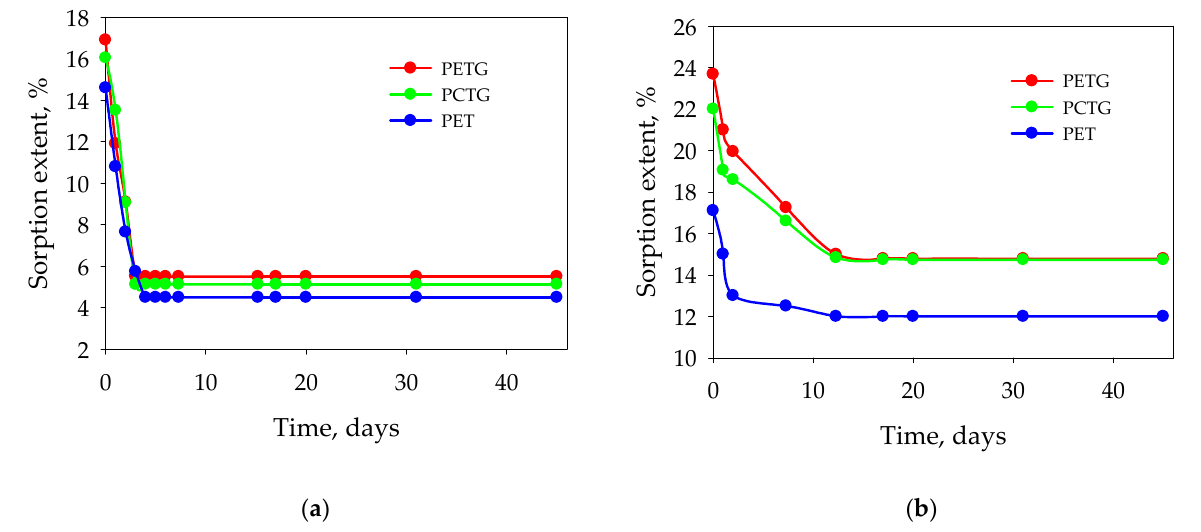
Figure 4. Desorption of acetic acid esters from polyesters: ( a )—ethyl acetate, ( b )—butyl acetate. A long-term study of the residual ester content shows a very slow decrease in ester content over time. At 20 ◦ C and ambient pressure, the ester content can decrease to 0.9% by weight after one year of desorption. The slow rate of desorption in the equilibrium zone is significantly affected by temperature. At 60 ◦ C, complete desorption for PETG and ethyl acetate can be achieved after 27 days. At 60 ◦ C and vacuum (pressure 10 kPa), complete desorption for the same system is achieved in 36 h. For other polyesters, complete desorp- tion can be reached in a similar way but within a different time period. The desorption of esters from polyesters is relatively slow, which offers the possibility to control the residual ester content by choosing specific conditions for the desorption process.